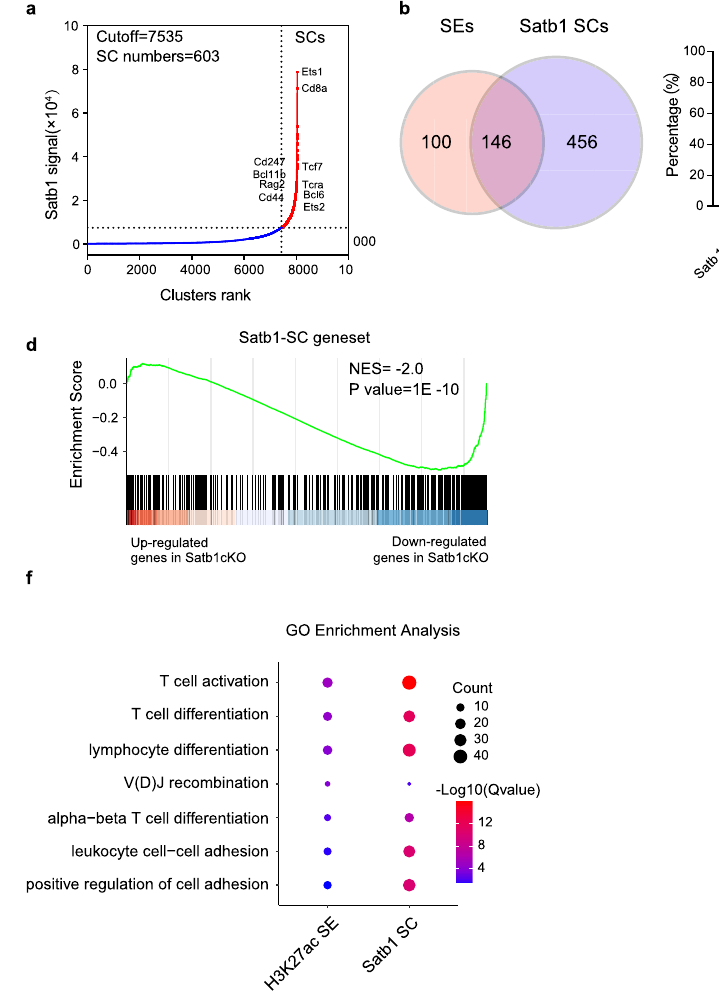
Fig. 3 | SATB1 clusters are associated with cell identity genes. a Hockey-stick plots showing clusters ranked by normalized Satb1 ChIP-seq signals in DP thymo- cytes using the ROSE algorithm. SCs, super-clusters. Details of Satb1-super-cluster and their associated genes can be found in Supplemental Data S5. b Venn diagram (left) showing the overlap of Satb1 super-clusters and H3K27ac super-enhancersin WT DP thymocytes.Column plot (right) showing theoverlapof Satb1-binding sites with H3K27ac peaks. ChIP-seq data are the same as Fig. 2c. c Line plot showing H3K27acsignalsofSatb1super-clusterregionsinWTandSatb1cKODPthymocytes. Data represent the mean±SEM. d GSEA-enrichment plot for Satb1 super-cluster associatedgenesshowingasigni fi cantenrichmentofthegenesetindownregulated genes of Satb1cKO DP thymocytes. Nominal P value, calculated as two-sided t test,